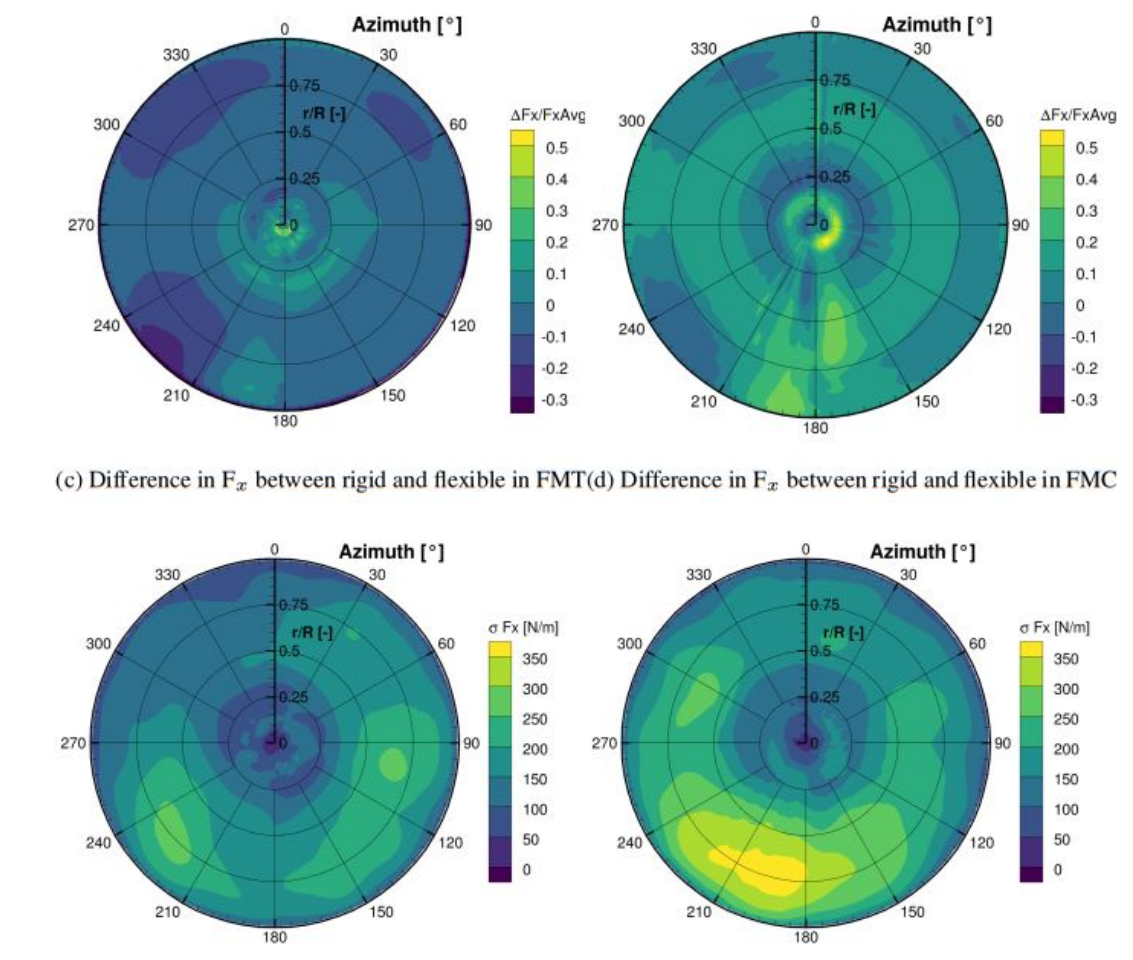
Wind Energ. Sci., 7, 1421–1439,